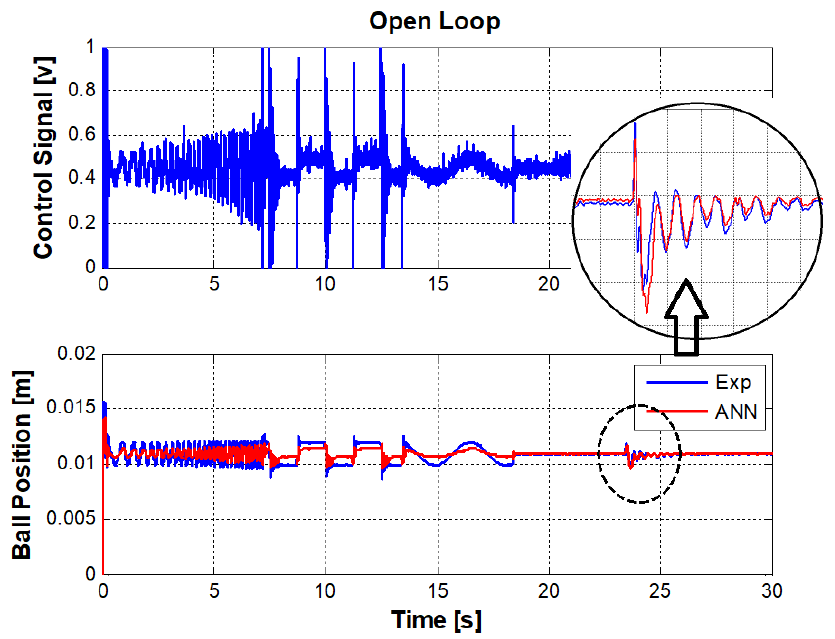
Figure 7. Input and output signals to train the NARX model for closed-loop model